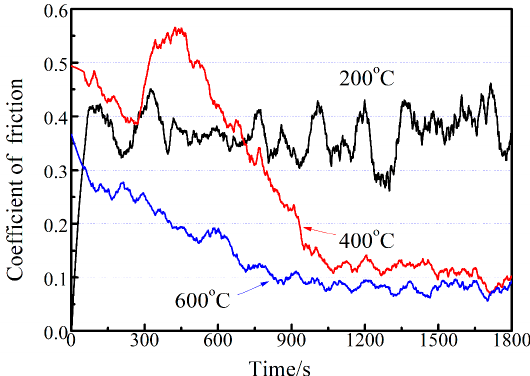
Figure 5. CoF of DLC films on steel ball / a-Si:H films under di ff erent temperatures.